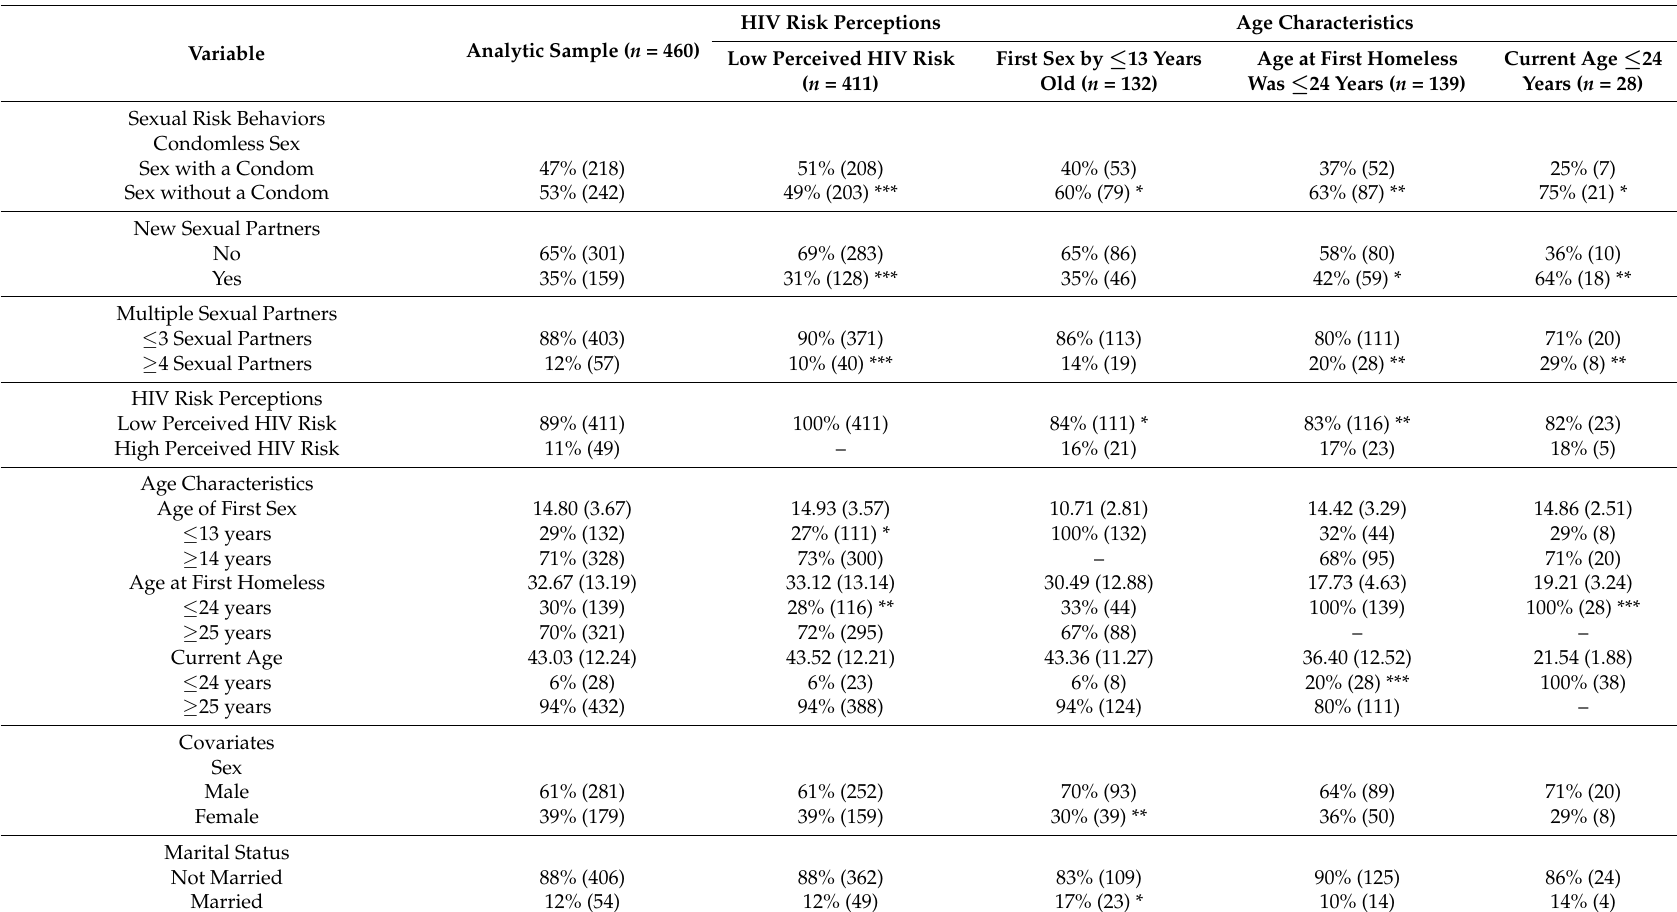
Table 1. Sample Characteristics by Sexual Risk Behaviors, % ( n ) or Mean